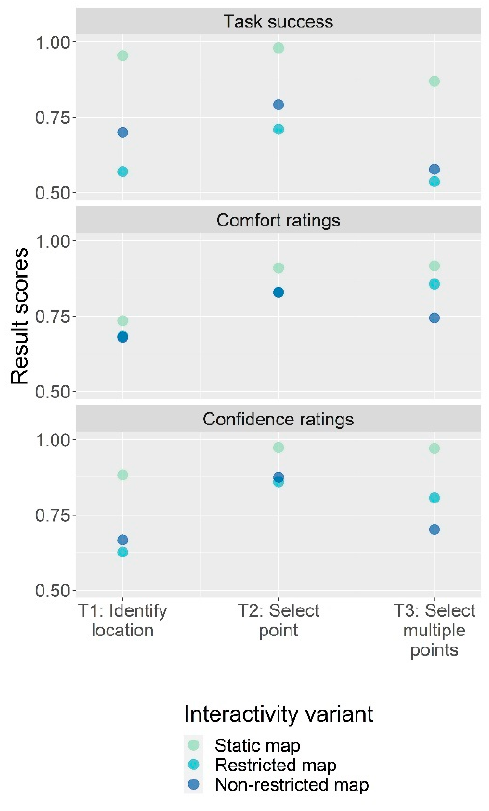
Figure 12. Task success, comfort, and confidence ratings of interactivity variant by map-reading tasks.